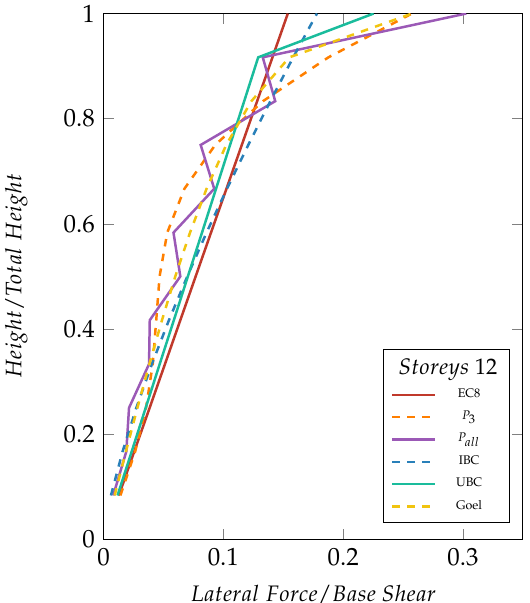
Figure 3. Lateral load pattern used to design the 12-storey SBM